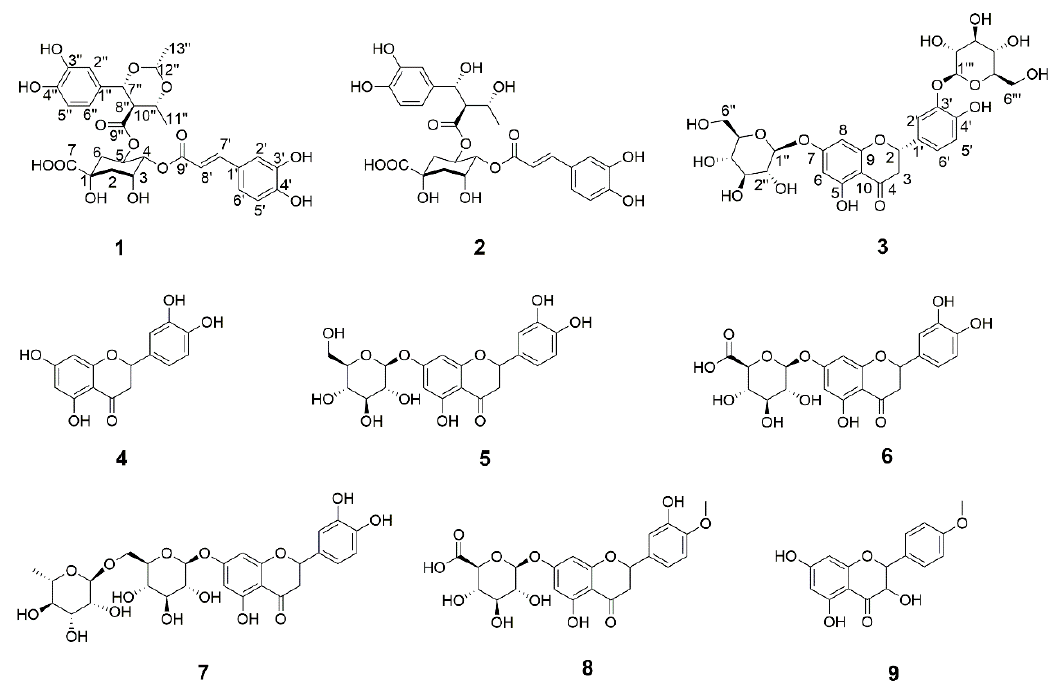
Figure 1. Chemical structures of compounds 1 – 9.